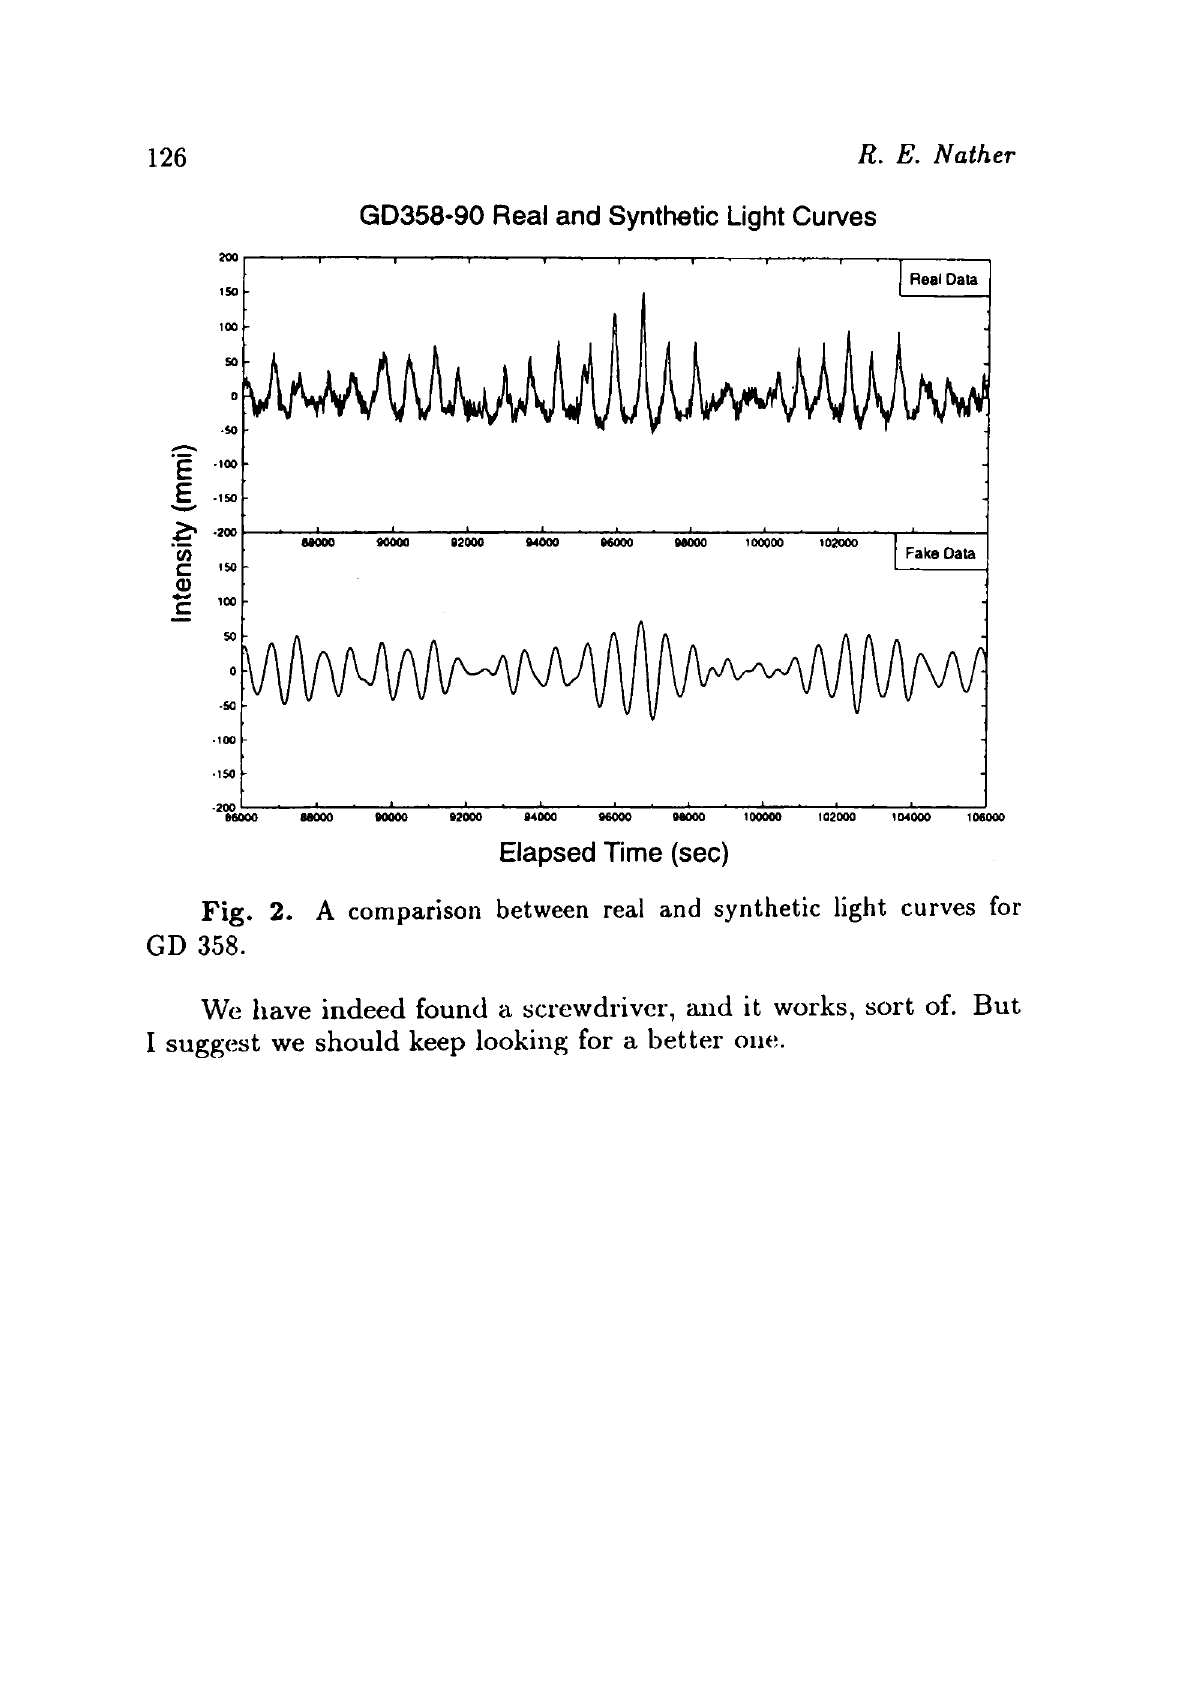
Fig. 2. A comparison between real and synthetic light curves for GD